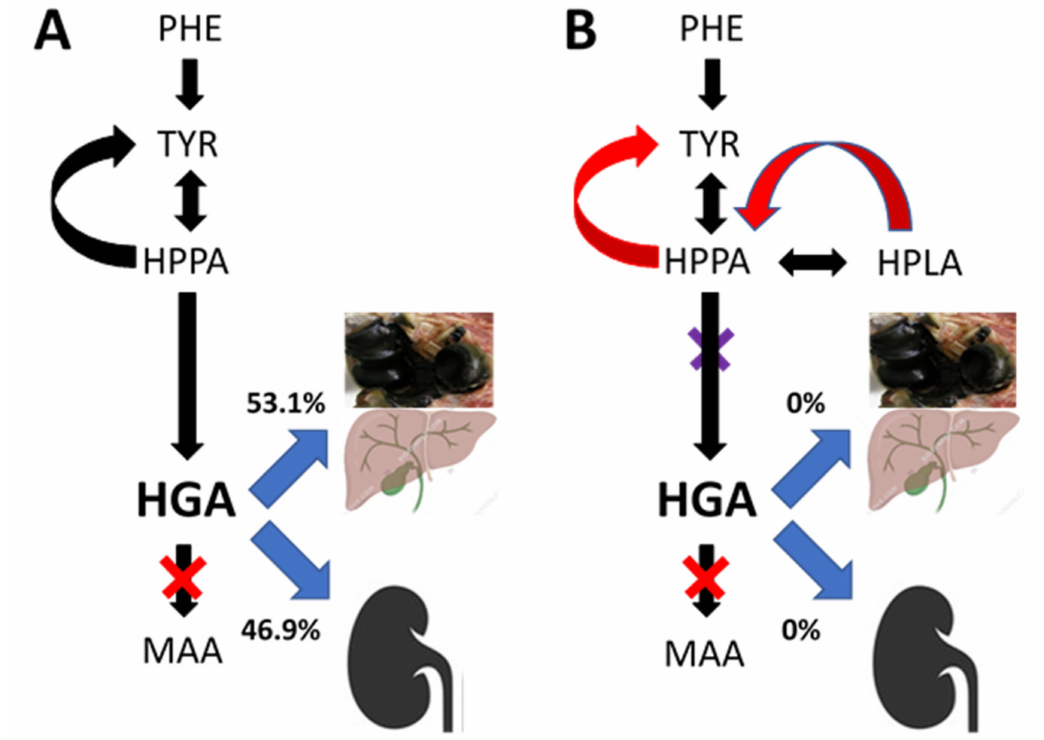
Figure 4. Diagrammatic representation showing that HGA accumulates in AKU due to a deficiency of homogentisate dioxygenase (denoted by the red X), with a measured spill-over into urine as well as predicted biliary excretion and accumulation in the body as pigment. In AKU (Panel ( A )), circu- lating HGA is in low concentration relative to urinary excretion and therefore the urinary excretion is dominant. However, data during nitisinone (reflecting 4-hydroxyphenylpyruvate dioxygenase inhibition denoted by the purple) show that 53.1% of TYR flows into the non-urinary pathways including biliary and pigment pathway and only 46.9% is excreted in the urine, following 10 mg nitisinone daily for 4 weeks. Panel ( B ) shows the complete inhibition of HGA urinary and bil- iary excretion as well as HGA deposition and the suggested mechanism for metabolite generation during nitisinone treatment. (PA: phenylalanine; TYR: tyrosine; HPPA: 4-hydroxyphenylpyruvate; HPLA: 4-hydroxyphenyllactate; HGA: homogentisic acid; MAA: maleylacetoacetic acid) (Image of pigmented elbow joint denotes the total body ochronotic process; that of the liver denotes the biliary excretion, while the kidney image denotes urinary HGA